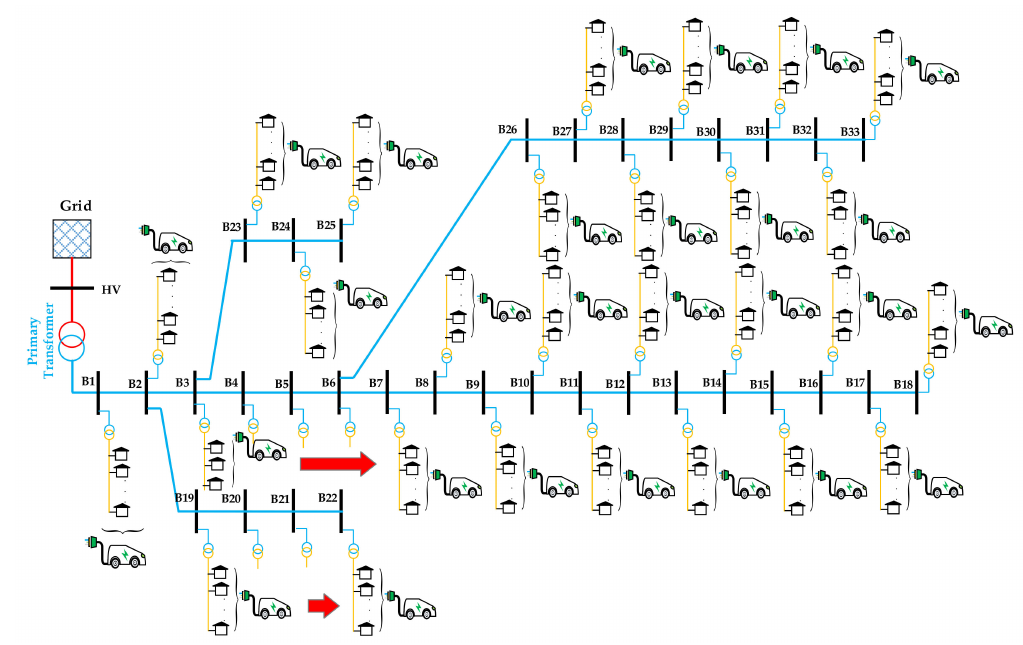
Figure 1. Plug-in electric vehicles (PEVs) connected in a radial distribution